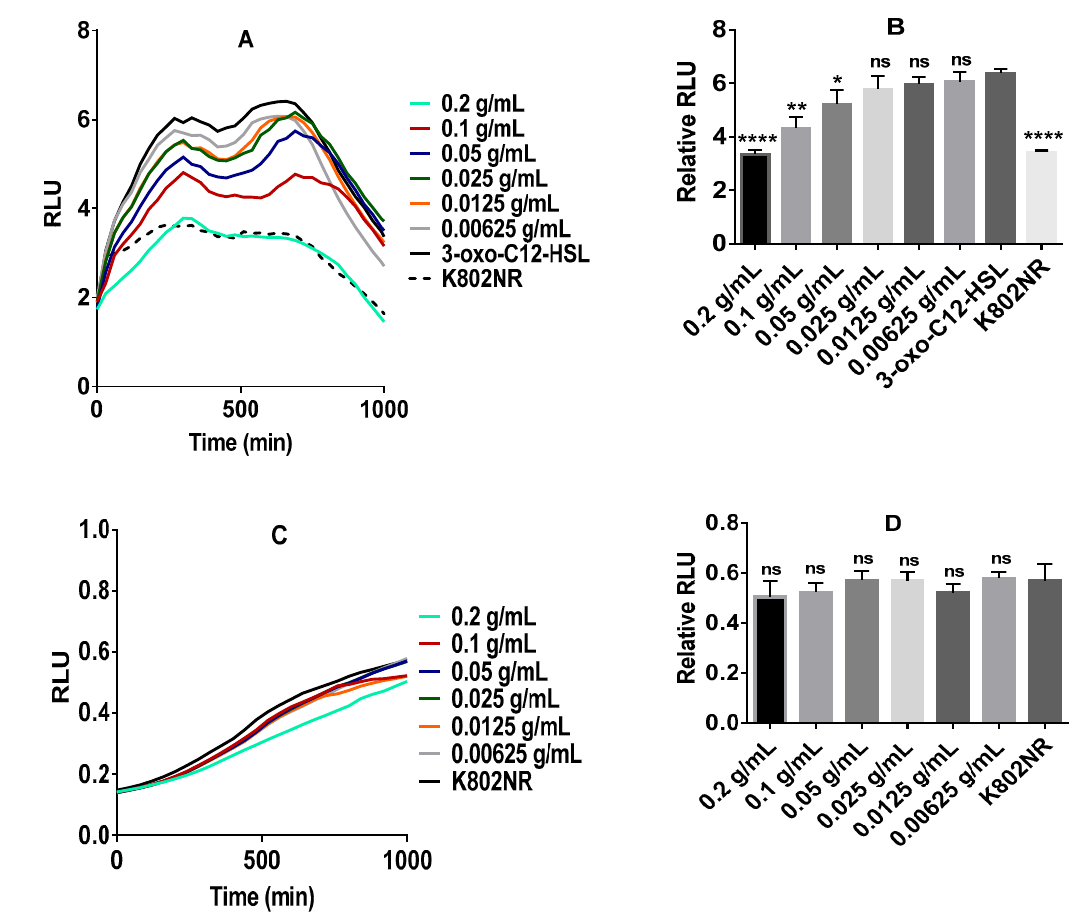
Figure 1. Anti-QS activity of CSHS. ( A ) Inhibitory effect of CSHS on the bioluminescence emission of K802NR reporter strain; ( B ) inhibitory effect of CSHS on K802NR bioluminescence emission relative to the control, consistent with the data in panel A; ( C ) growth response of K802NR reporter strain in the presence of CSHS; ( D ) growth response of K802NR in the presence of CSHS relative to the control, consistent with the data in panel C. Error bars are not shown in A and C to ensure clarity of figures. The final concentration of 3-oxo-C 12 -HSL was 5 × 10 − 10 M. All presented concentrations are the final concentrations. The amount of luminescence is expressed in relative light units or RLUs. * p < 0.05, ** p < 0.01, **** p < 0.0001, and ns not significant. Values represent mean ± SD, n = 3 (three different experimental readings).